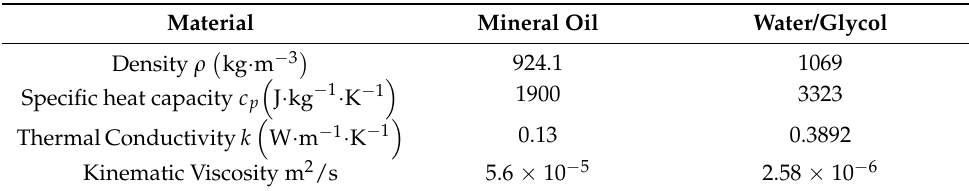
Table 4. Thermo-physical properties of coolant materials [29].